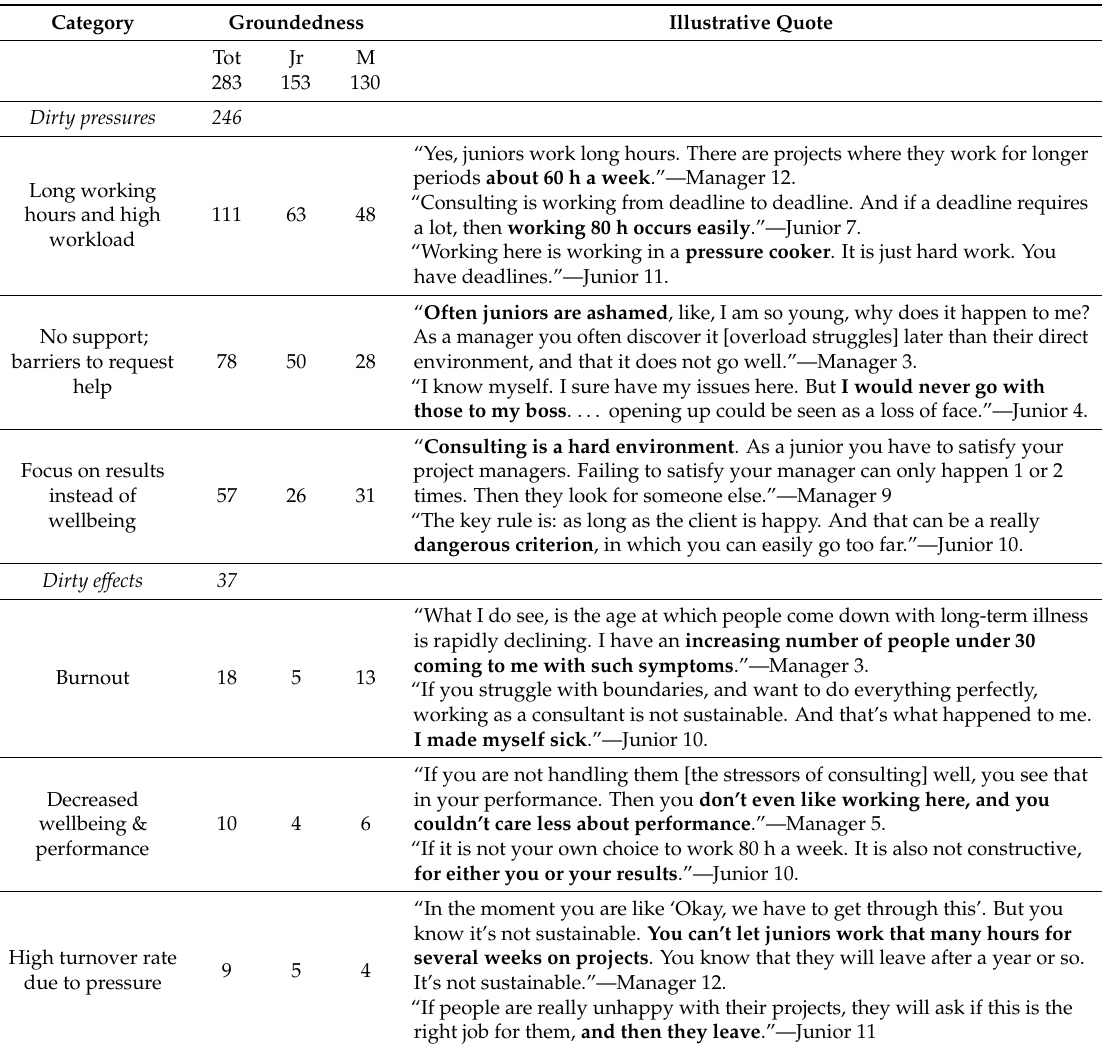
Table 5. Management-induced pressures perceived as morally